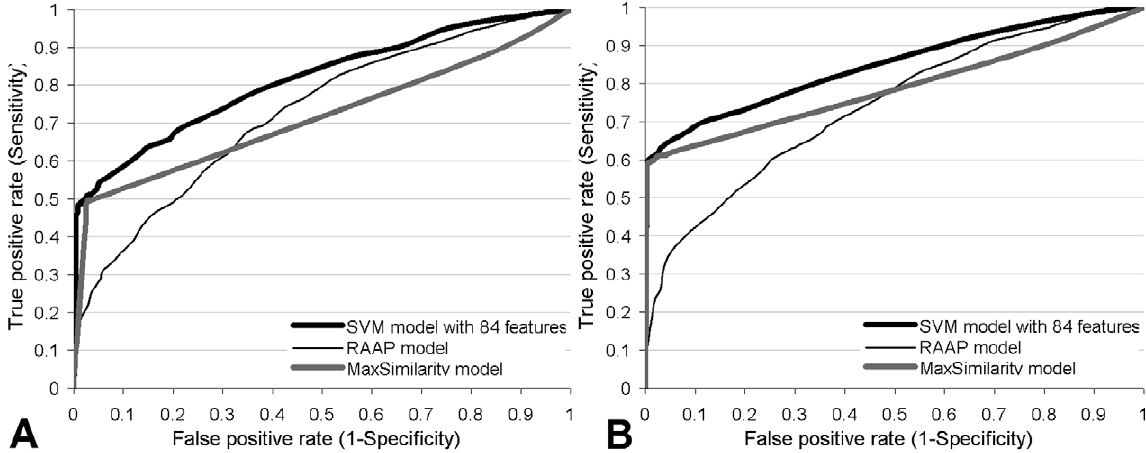
Figure 2. Receiver operating characteristic (ROC) curves for the SVM model with 84 features, RAAP and MaxSimilarity models. The curves were computed based on the 10-fold cross validation on the BCPREDFrag dataset (panel A) and ChenFrag dataset (panel